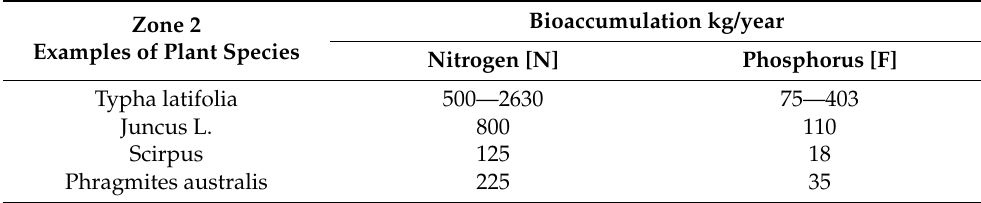
Table 5. Plant species occurring in the area of the Vistula valley in its upper course based on